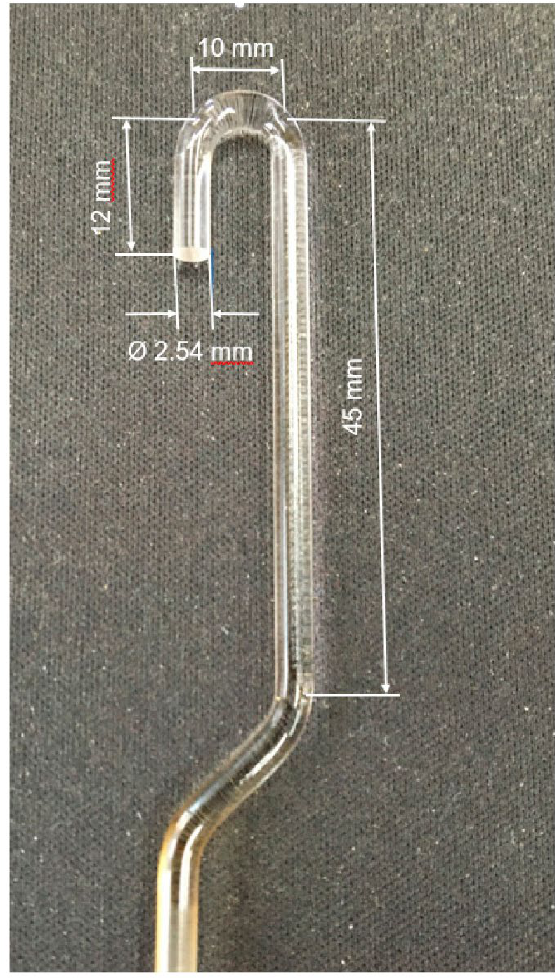
Figure 1. EXPANSION probe.